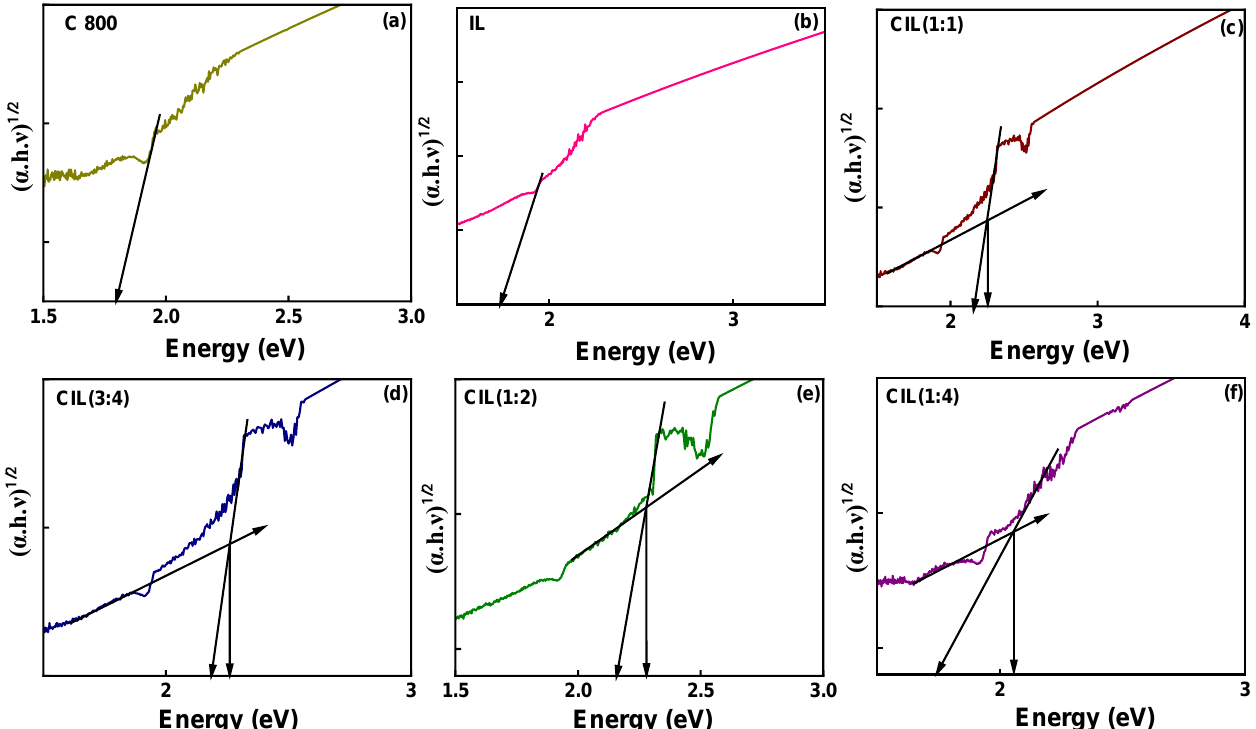
Figure 8. Tauc plots showing the indirect transitions of the synthesized materials. ( a ) C 800; ( b ) IL;